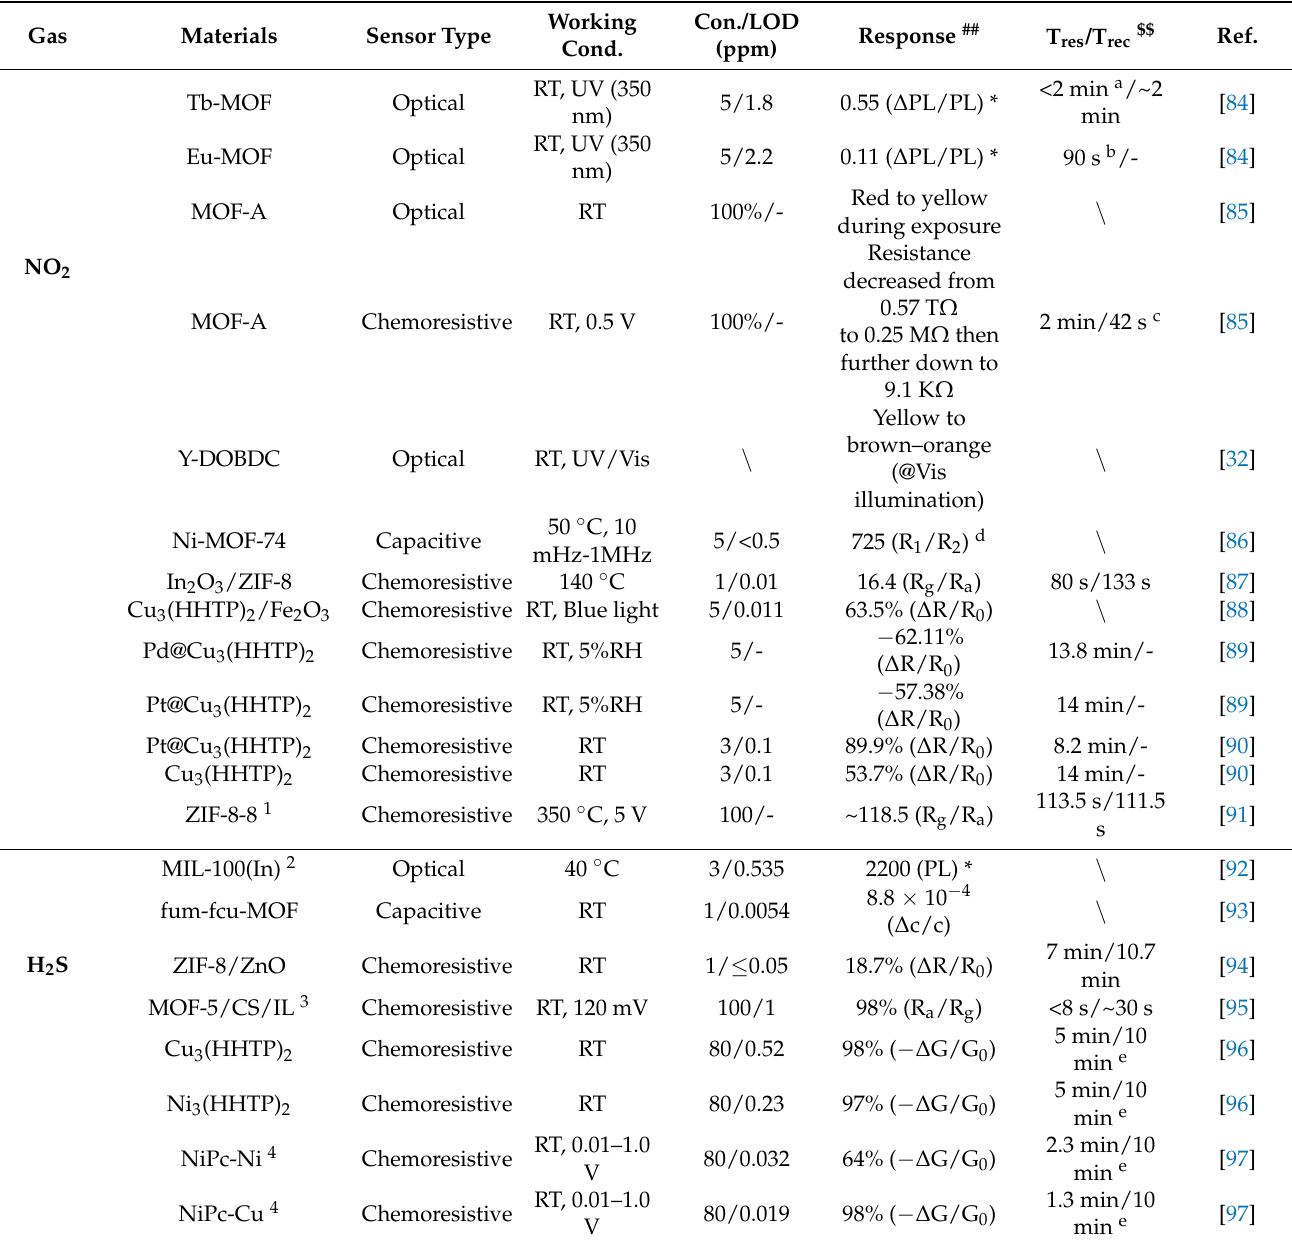
(Table 1). We focus on the impact of nanostructured morphologies, metal nodes, organic linkers, and functional groups, as well as gas-sensing mechanisms on the performance of state-of-the-art sensing technologies. We conclude with a review of the rapidly emerging trends and promising strategies that can enhance functionality and enable the production of the next generation of highly sensitive and selective MOF-based gas sensors for the low-temperature detection of gas molecules. Table 1. Key features of MOF-based gas sensors for air quality